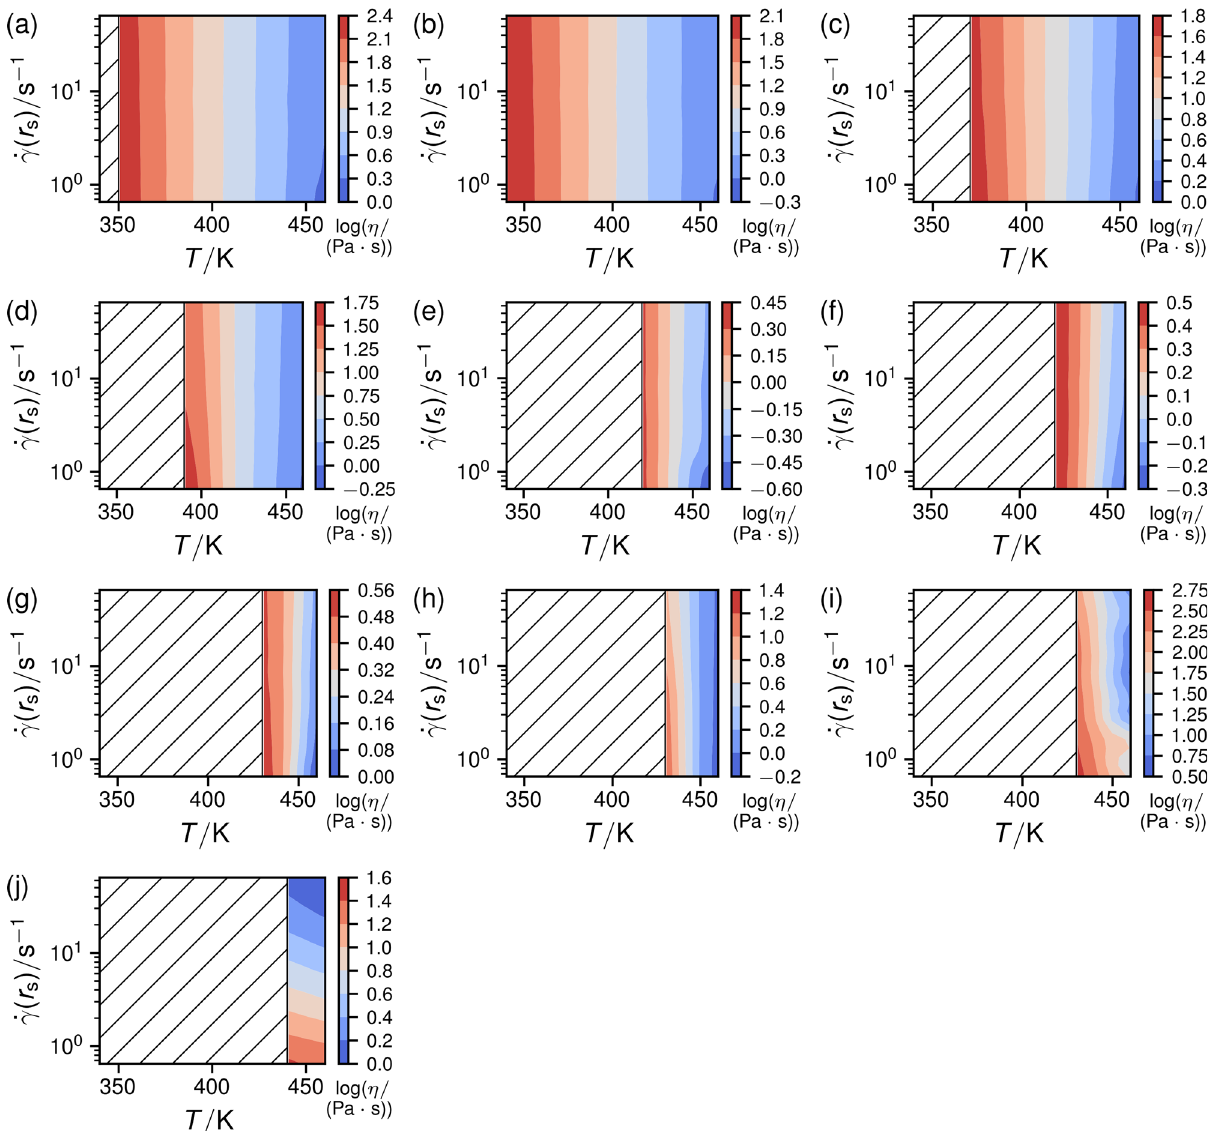
Figure 2: Logarithms of the viscosities over temperature and shear rates at the particular radii for ( a )